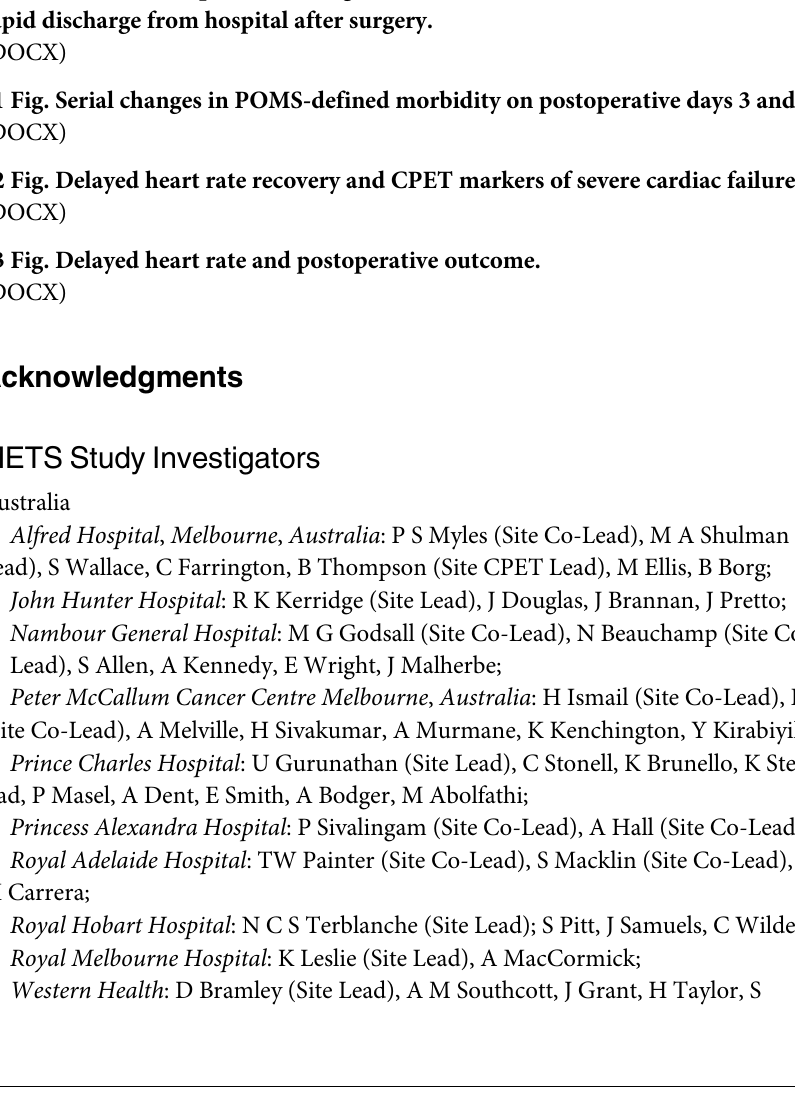
S4 Table. Relationship between magnitude of HRR and factors associated with patients being free of morbidity within 5 days of surgery.